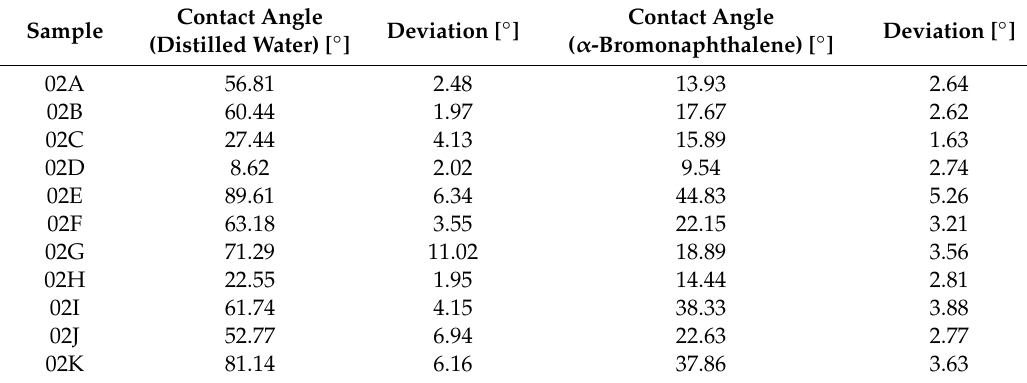
Table 7. Wetting angles of oxide coatings produced in anodizing process and thermo-chemical treatment for distilled water and α -bromonaphthalene.